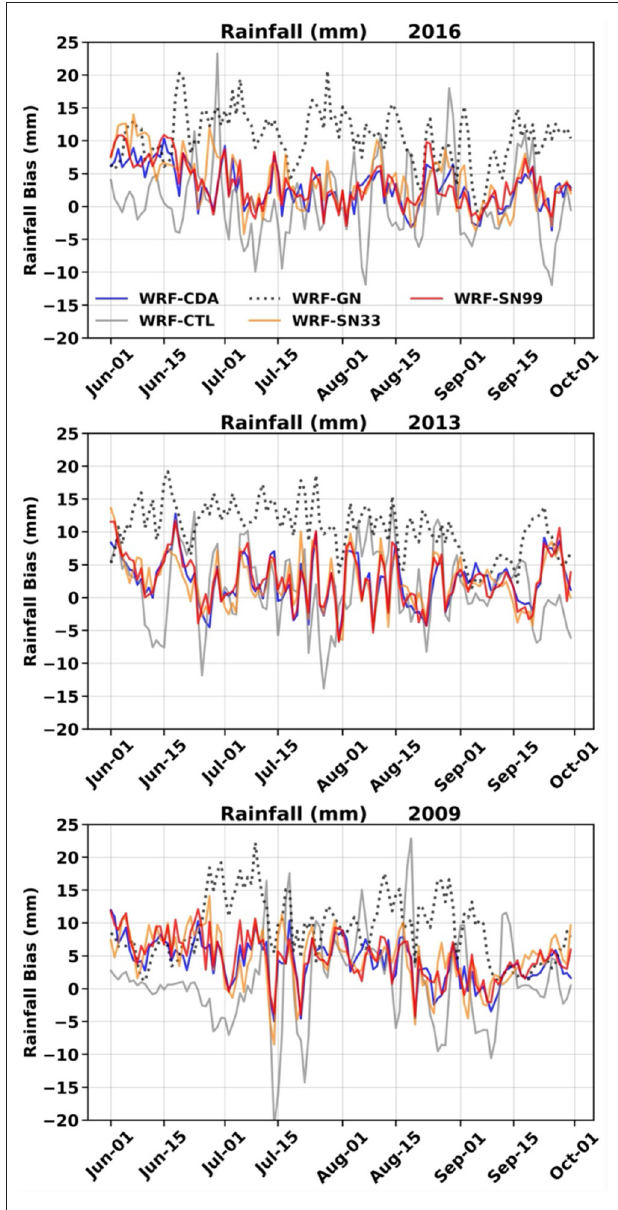
FIGURE 3 | Time-series of the rainfall differences (Model-IMD) during normal (2016), excess (2013), and drought (2009) Indian Summer Monsoon seasons. The rainfall is averaged over the monsoon core region (74.5–86.5 ◦ E and 16.5–26.5 ◦ N).